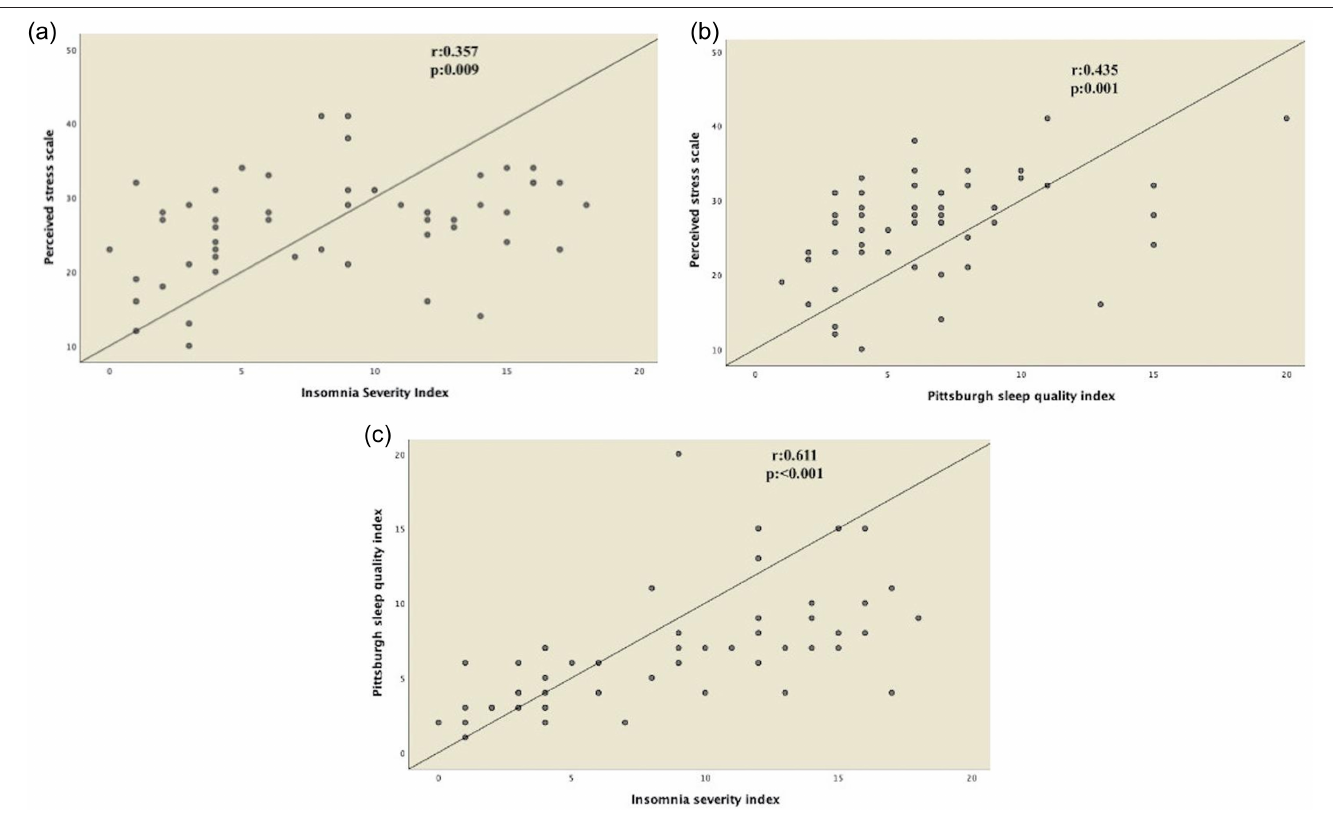
Figure 1. a) Correlation analysis between perceived stress and ISI score. b) Correlation analysis between perceived stress and PSQI. c) Correlation analysis between PSQI and ISI.